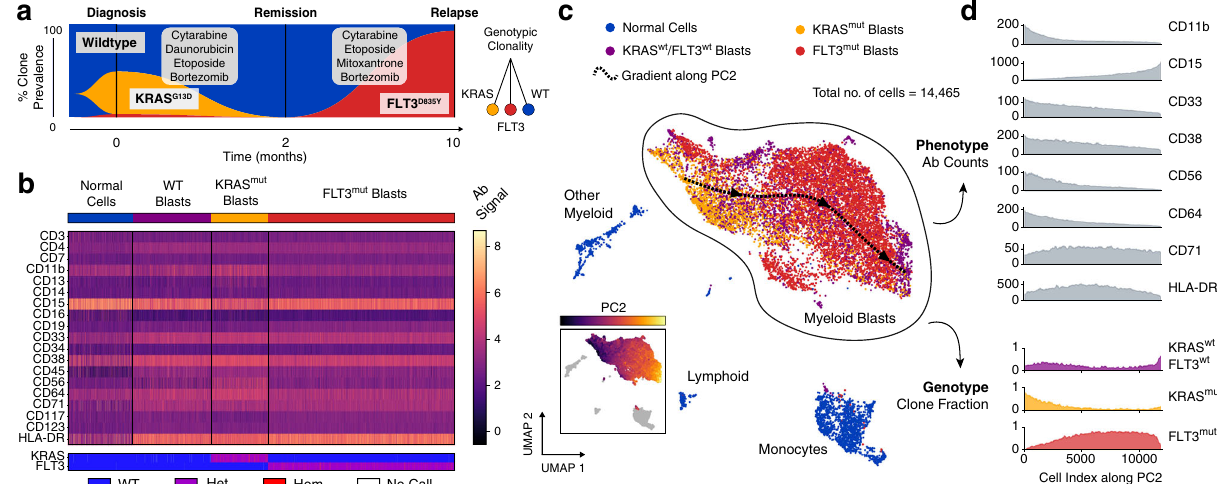
Fig. 4 Distinct genetic subclones form an overlapping immunophenotypic continuum in a case of pediatric AML. a Three timepoints sampled with DAb- seq during treatment comprise a mixture of independent clones (KRAS G13D heterozygous blasts, yellow; FLT3 D835Y blasts, red). The wild-type compartment contains additional cells with a blast-like immunophenotype lacking detectable mutations. b Heatmap of log-transformed corrected antibody counts and genotyping calls for the KRAS and FLT3 loci for each cell across all timepoints. The heatmap is grouped by genotype. Cells with wild-type genotype but blast-like immunophenotype are labeled separately. c UMAP embedding of all cells from all timepoints based on log-transformed corrected antibody counts. Color indicates mutation status as in a . The blast compartment is overlaid with a spline approximating the gradient of the second principal component of the antibody count matrix (shown in inlet fi gure) and indicates a gradual change in immunophenotype. d Moving average expression of antibodies and fraction of mutated cells sorted by the second principal component of the antibody count matrix. The overlapping phenotypic continuum between the genetically distinct blast clones is apparent. Source data are provided as a Source data fi FLT3 -ITD immunophenotype is primarily CD71 + erythroid (82.2% of FLT3 -ITD cells), with minor fractions in the Blast 3